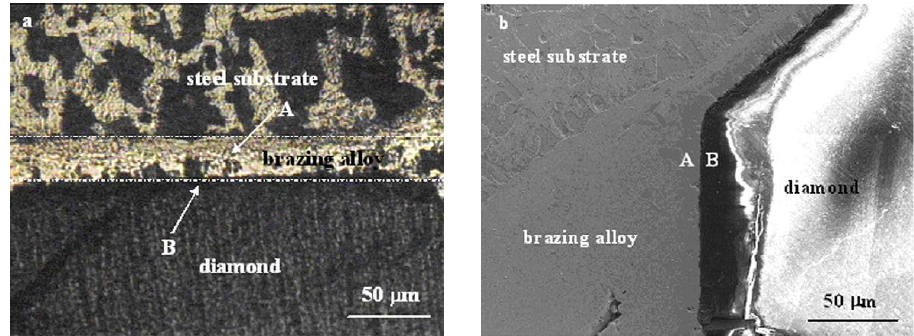
Figure 7. ( a ) Optical micrograph; ( b ) SEM photograph of the interface between brazing alloy, diamond and steel substrate [21]. Reproduced with permission from Journal of Alloys and Compounds, Elsevier, 2009.